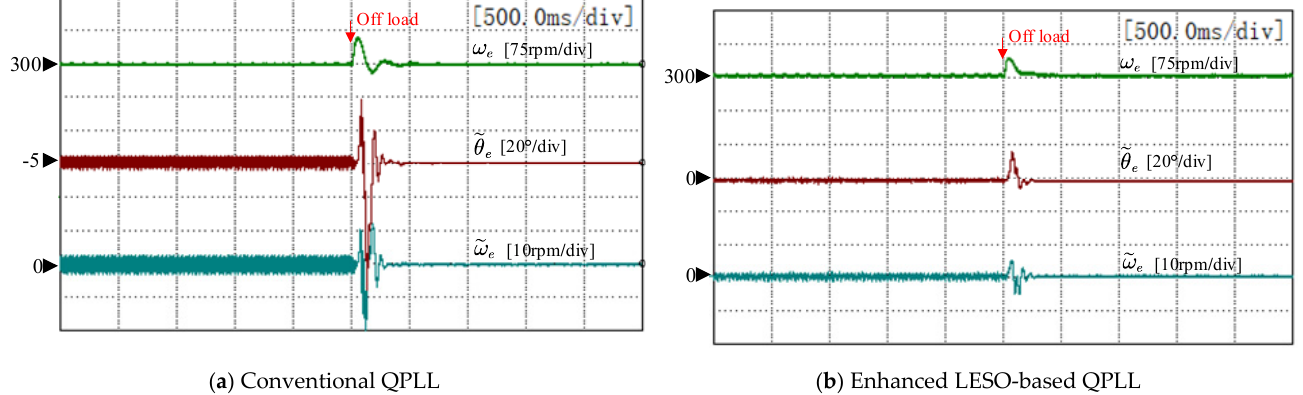
Figure 16. Experimental results of the real speed, the position estimation error, and the speed estimation error at 300 rpm under load torque disturbance (5 N·m → 0 N·m).